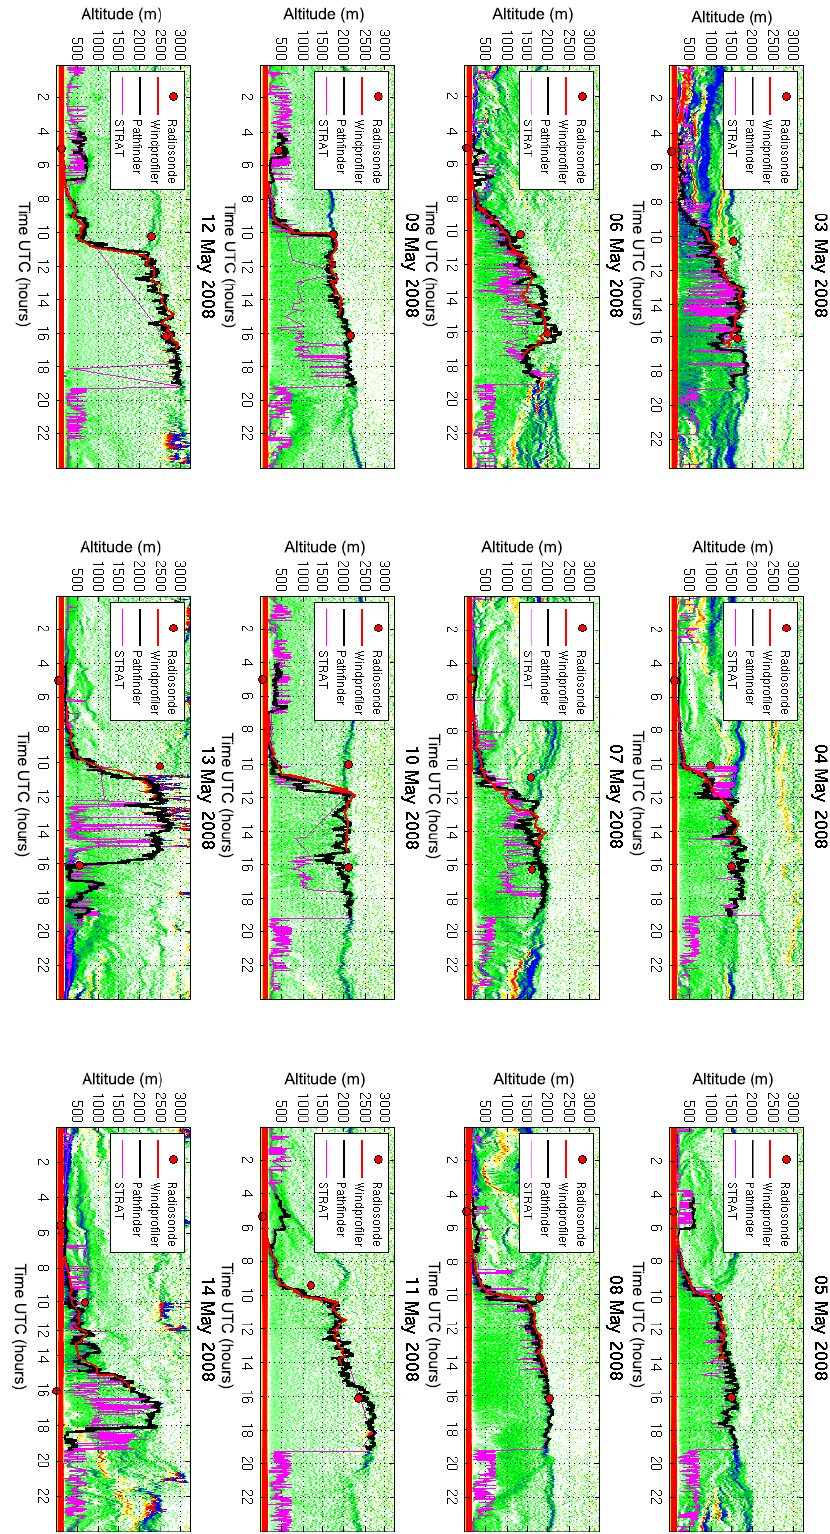
Figure 10. Overview of MLH retrievals from pathfinder MLH L,P , STRAT2D MLH L,S , Wind profiler MLH W and Radiosonde MLH R for the 12 days of IMPACT data from 2008, shown against the background of the ALS450 RCS gradient